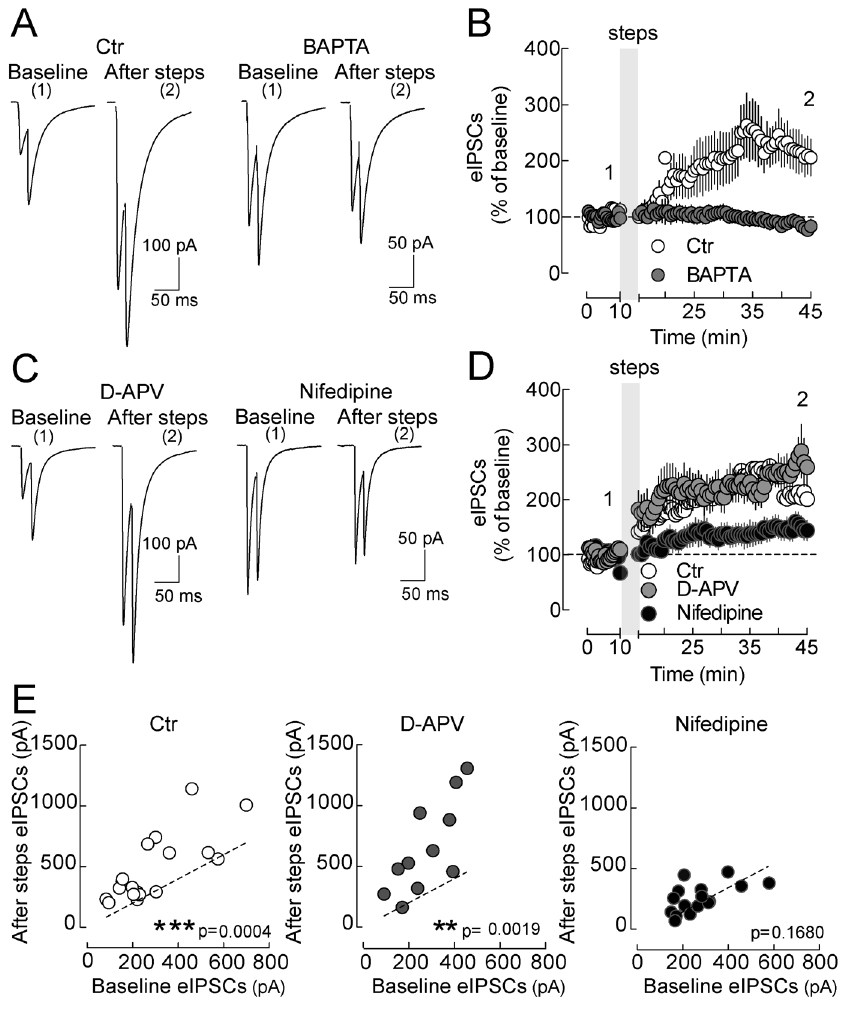
Figure 5. Elevation of postsynaptic calcium through L-type Ca 2 + channels is necessary to induce LTPi. (A) Representative eIPSC traces recorded from two pyramidal neurons before (baseline) and 20 min after LTPi-inducing depolarizing steps. The left neuron was intracellularly perfused with 0.2 mM EGTA (Ctr), the right neuron with 20 mM BAPTA. Note that in the presence of the fast Ca 2 + chelator LTPi could not be induced. (B) Population time courses of normalized IPSCs in the two conditions of (A). (C, Left) Representative eIPSC traces recorded from a pyramidal neuron expressing LTPi in the presence of the NMDA receptor antagonist (D-APV, 50 m M). (C, Right) Representative eIPSC traces of another pyramidal neuron, in which LTPi was prevented by the L-type Ca 2 + channel blocker nifedipine (10 m M). (D) Population data plots of the two pharmacological applications of (C). (E) Plots of individual eIPSC amplitudes before ( x -axes) versus 20 min after depolarizing steps ( y -axes) in control (ctr), D-APV, and nifedipine. In (C–E), white, grey, and black symbols refer to control, D-APV, and nifedipine, respectively. Data are single values and/or mean 6 SEM. ** p , 0.001; *** p , 0.0001. Further analyses are illustrated in Figure S4A. Numbers 1 and 2 refer to times of trace illustration.